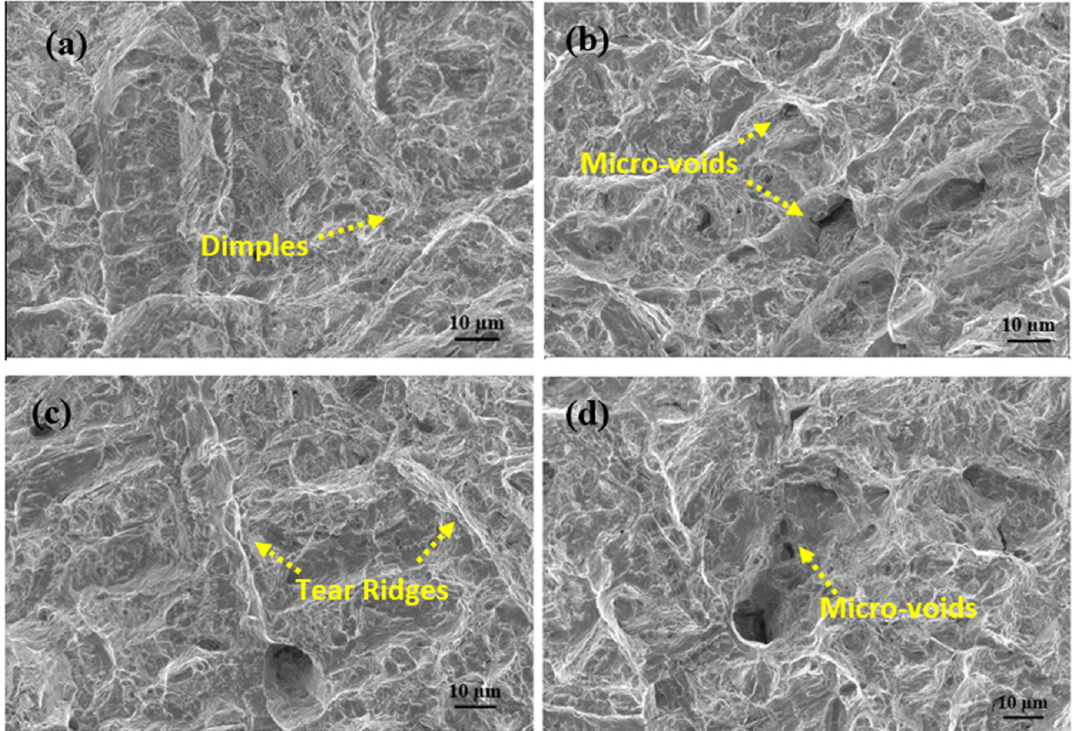
Figure 18. FESEM of tensile fractography surface of Cu alloy and Cu-(3, 6, 9) wt.% WC-Gr hybrid composites.